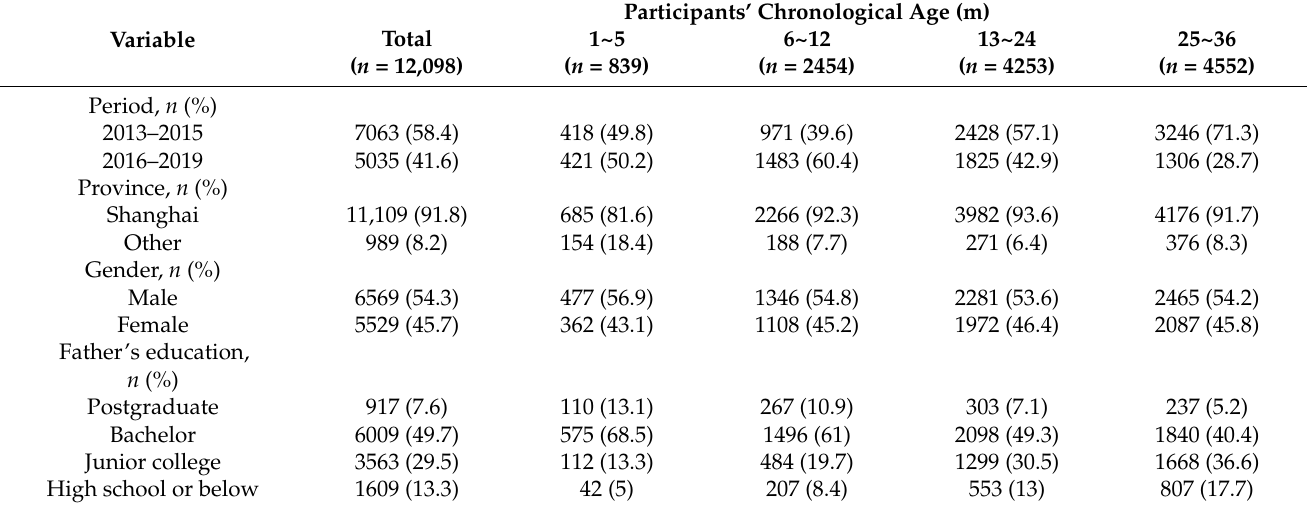
Table 1. Distribution of period, province, gender, parents’ educational, parents’